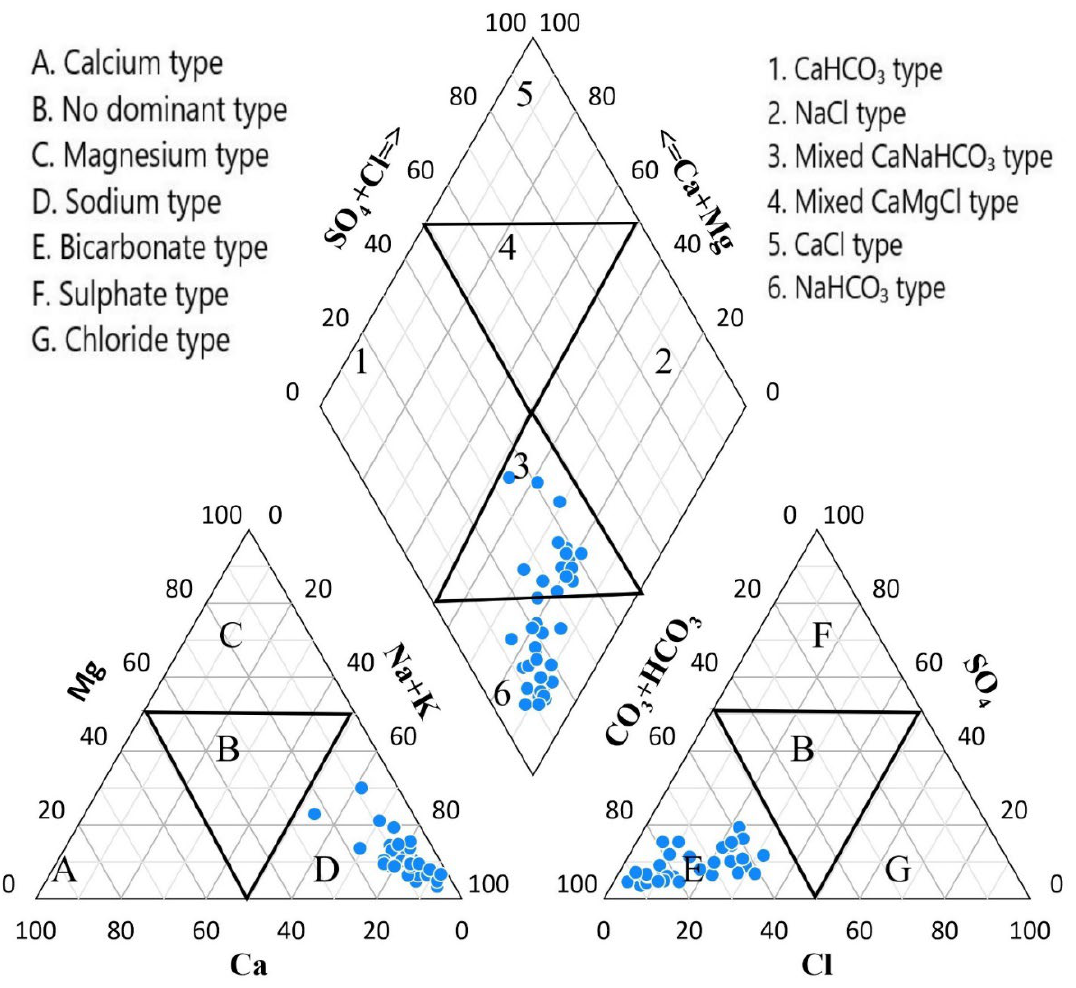
Figure 3. Piper diagram showing water type of the samples collected from community tube wells. The blue dots represnts the samples.